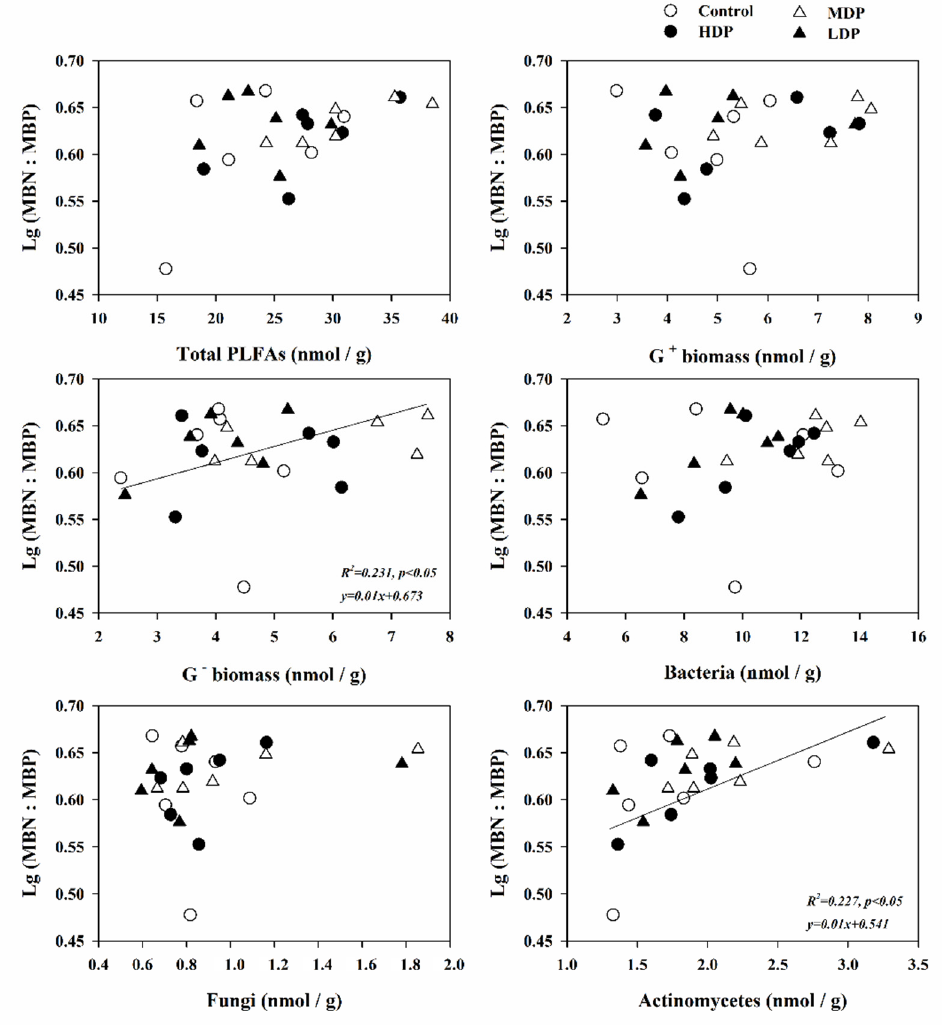
Figure 5. Relationships between MBN:MBP ratio and soil microbial groups in L. principis-rupprechtii plantations with different density.